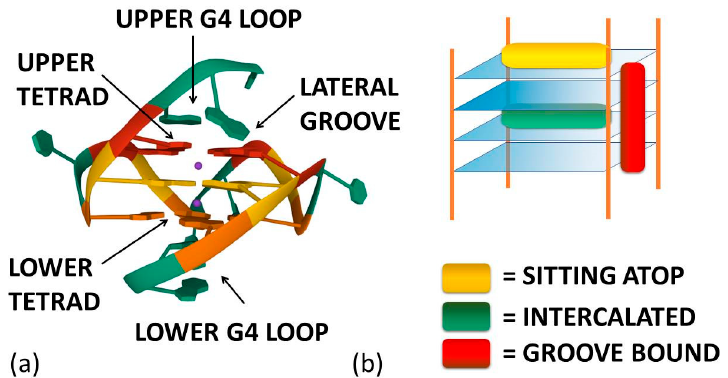
Figure 2. ( a ) Ligand–G4 interaction sites (the structure is PDB-1XAV, a monomeric parallel-stranded G4 from human c-MYC promoter). ( b ) Ligand–G4 complex types cartoon: the yellow rectangle refers to a species whose G4 interaction is driven by upper G4 stacking; the green one refers to a species able to intercalate itself between two adjacent tetrads; the red one refers to a molecule that chooses lateral grooves as the preferred binding site.